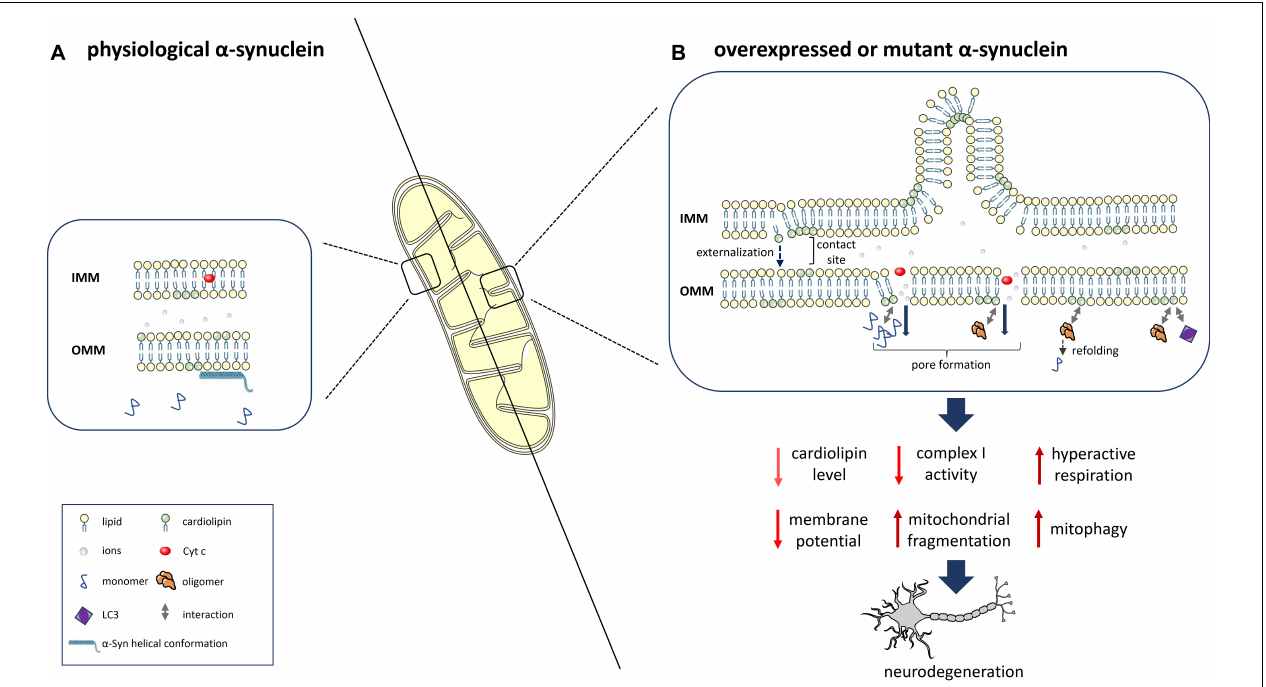
FIGURE 1 | α -Syn interaction with the mitochondrial phospholipid cardiolipin (CL) and downstream consequences. (A) At physiological levels, α -Syn binds to mitochondrial membranes in a helical conformation and does not impact CL levels. (B) α -Syn overexpression, mutation or knockout determines reduced levels, an altered composition and oxidation state of CL and the translocation of CL from the IMM to the OMM. Prolonged CL exposure leads to excessive mitophagy due to increased binding of CL to LC3. α -Syn also leads to OMM permeabilization due to pore formation, ion leakage, cytochrome c release, destabilization of the electron transport chain complexes and reduced complex I activity/hyperactive respiration. OMM-localized CL facilitates the refolding of α -Syn oligomers and fibrils. This figure was created using elements from Servier Medical Art, which is licensed under a Creative Commons Attribution 3.0 Unported Generic License